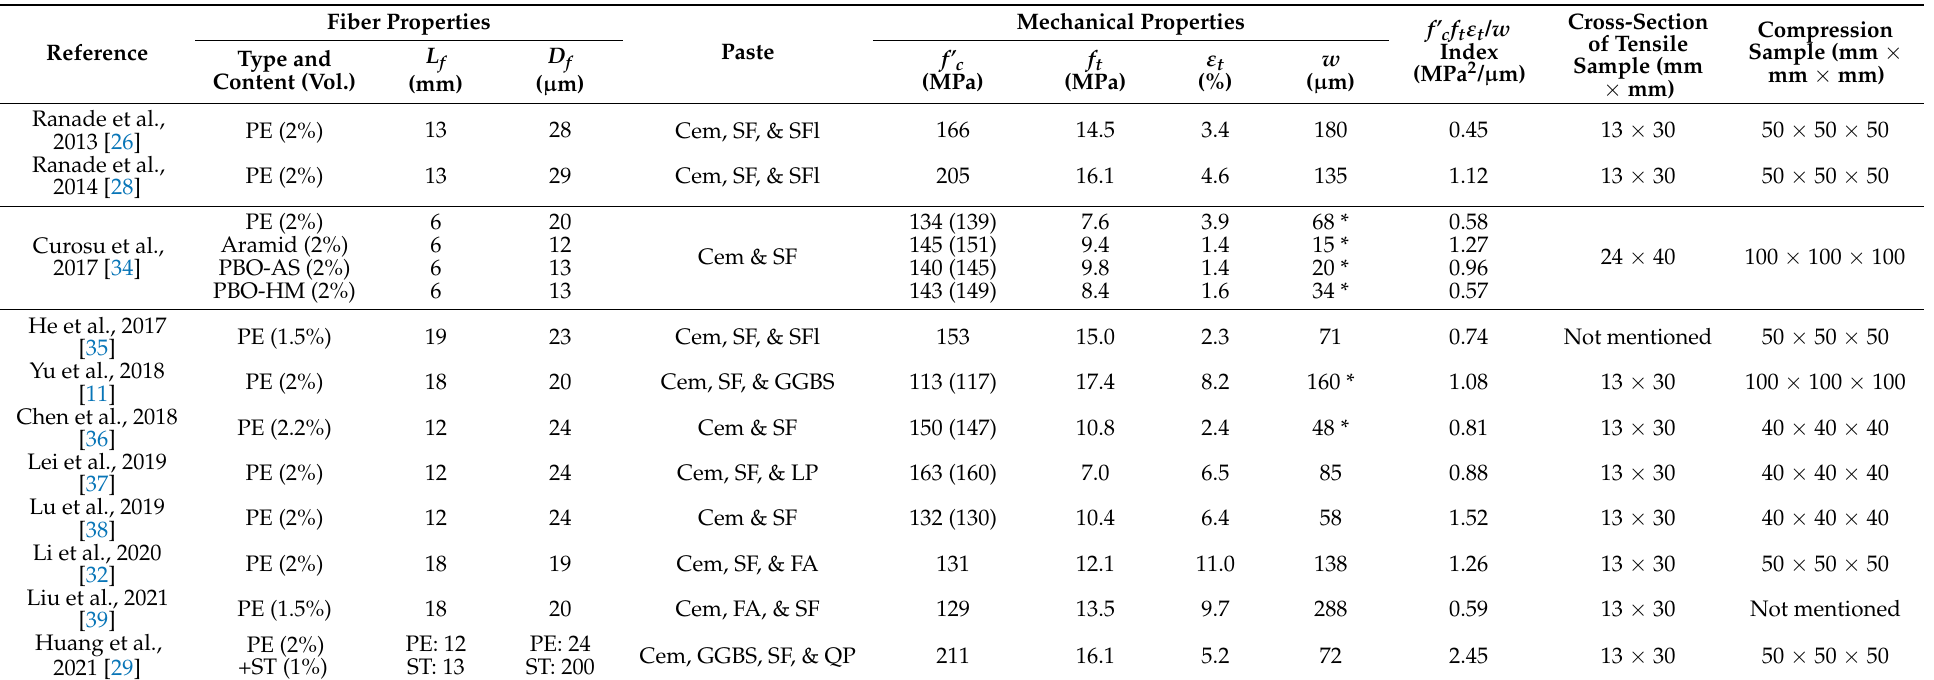
Table 1. Summary of strain-hardening UHPC with synthetic fibers in existing